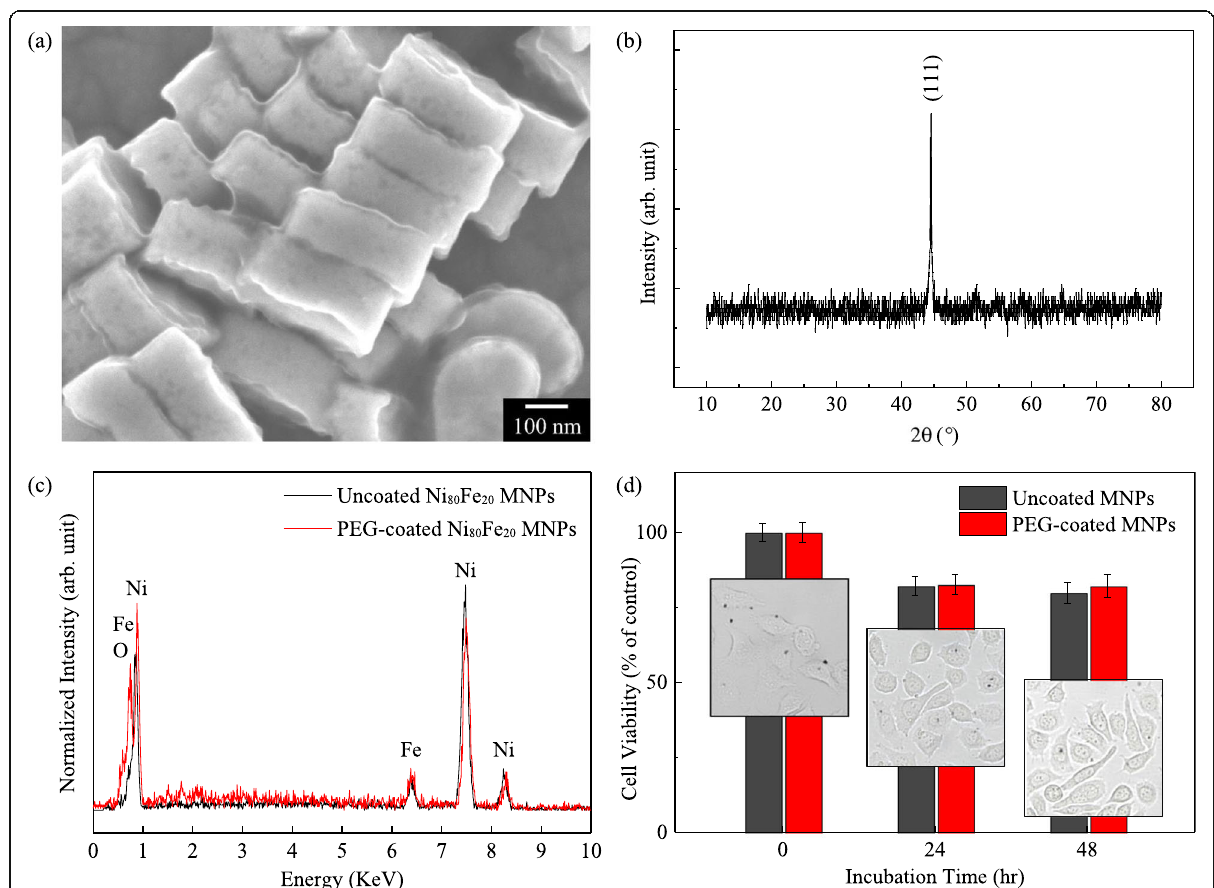
Fig. 2 a SEM image of NiFe MNPs with PEG coating. b XRD pattern for NiFe MNPs with PEG coating. c EDX pattern for NiFe MNPs with and without PEG coating. d Cell viability with displayed images of HeLa cells after incubation with MNPs, over a period of 0 – 48